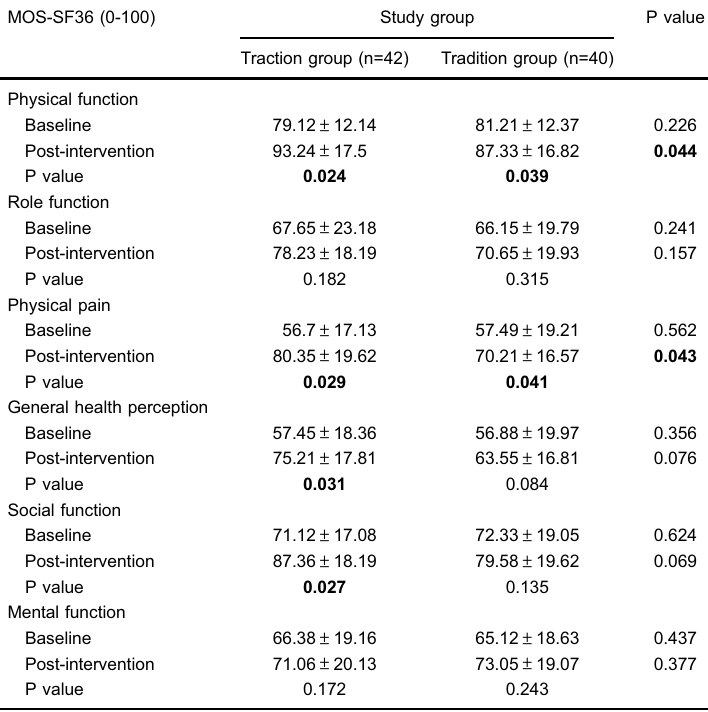
Table 3. Assessment of quality of life before and after the